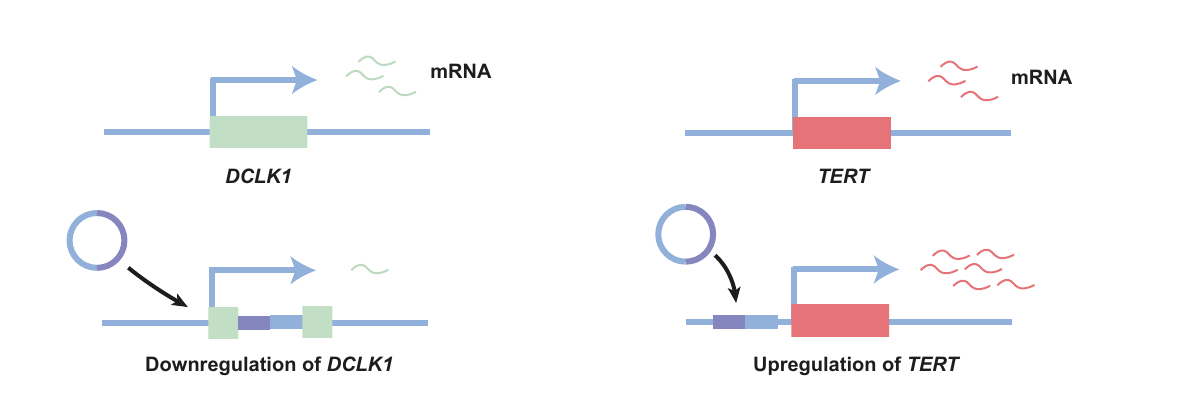
scores. 46,244 Subsequently, a series of studies were carried out to explore the molecular characteristics of eccDNA in tumors. Computational analysis of WGS data performed by Kim H. et al. showed that circular amplicons of ecDNA are more prevalent in aggressive cancers such as GBM.